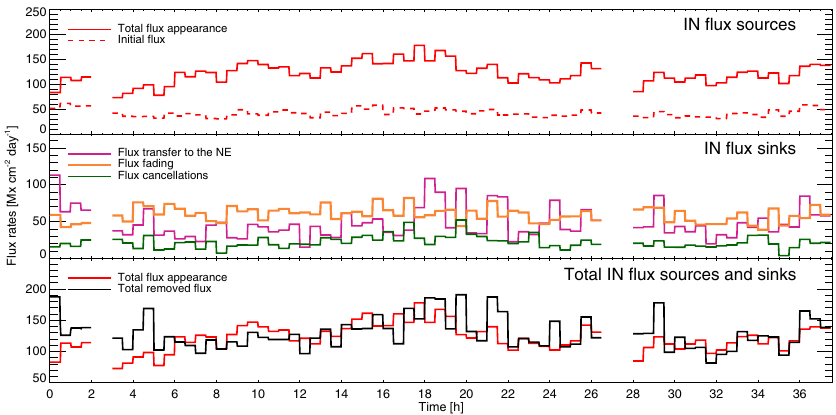
Fig.14 Sources and sinks of IN magnetic flux in the interior of a supergranular cell near the disk center, as observedbytheHinodeNFIon2–3November2010.Thetoppanelshowstheinstantaneousfluxappearance rates considering the total flux carried by the detected IN features (solid line) and only their initial flux (dashedline).Themiddlepaneldisplaystheratesatwhichmagneticfluxisremovedfromthecellbytransfer to the network (purple), in situ fading (orange) and cancellation (green). The bottom panel compares the total flux appearance and disappearance rates, computed by adding the three processes mentioned above. Image reproduced with permission from Goši´c et al. (2016), copyright by